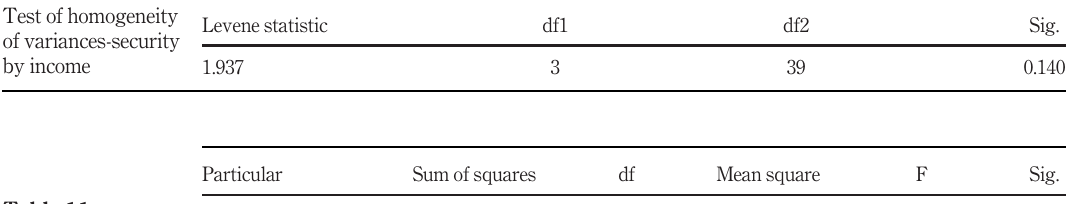
Table 11. ANOVA-security by income